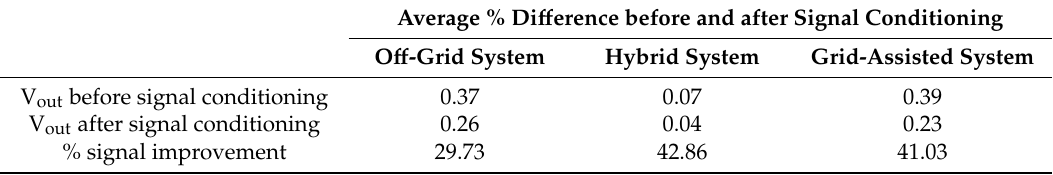
Table 2. Average percentage difference before and after signal conditioning for the three systems.